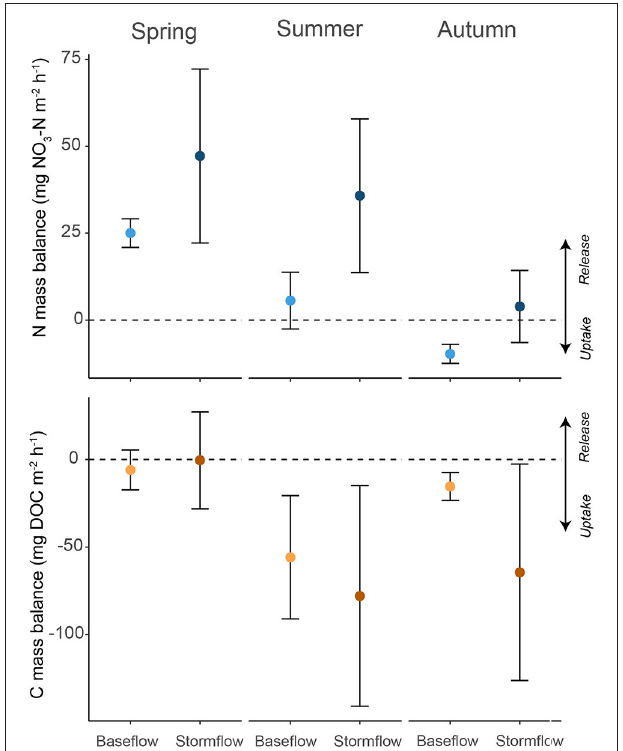
FIGURE 5 | Seasonal mean ( ± 95% CI) measurements of daily mean mass balance for NO − 3 -N and DOC. Data are separated by season and flow condition (i.e., baseflow and event